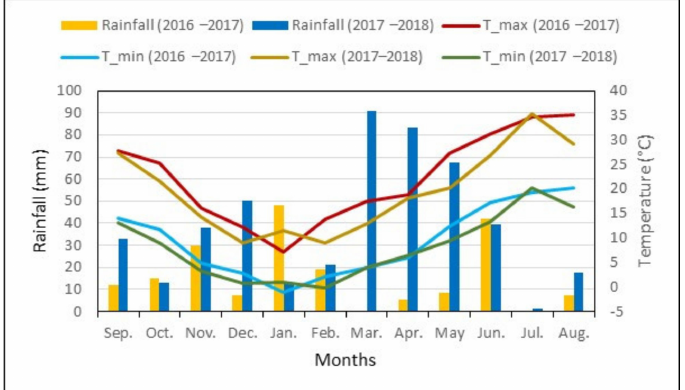
Figure 1. Monthly distribution of rainfall and minimum and maximum temperatures of the two growing seasons (2017 and